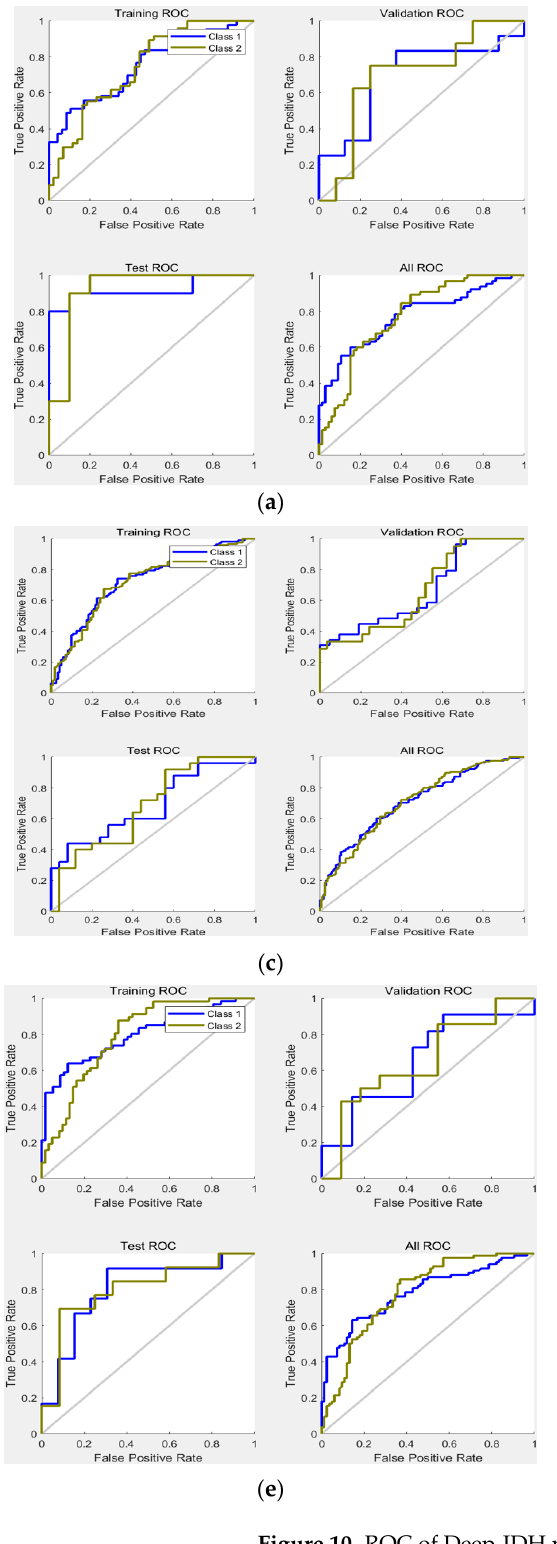
Figure 10. ROC of Deep ‐ IDH models using different hidden layers and data lengths: ( a ) 1 ‐ layer and 60 ‐ min data before IDH onset; ( b ) 1 ‐ layer and 45 ‐ min data before IDH onset; ( c ) 1 ‐ layer and 30 ‐ min data before IDH onset; ( d ) 2 ‐ layer and 60 ‐ min data before IDH onset; ( e ) 2 ‐ layer and 45 ‐ min data before IDH onset; and ( f ) 2 ‐ layer and 30 ‐ min data before IDH onset.